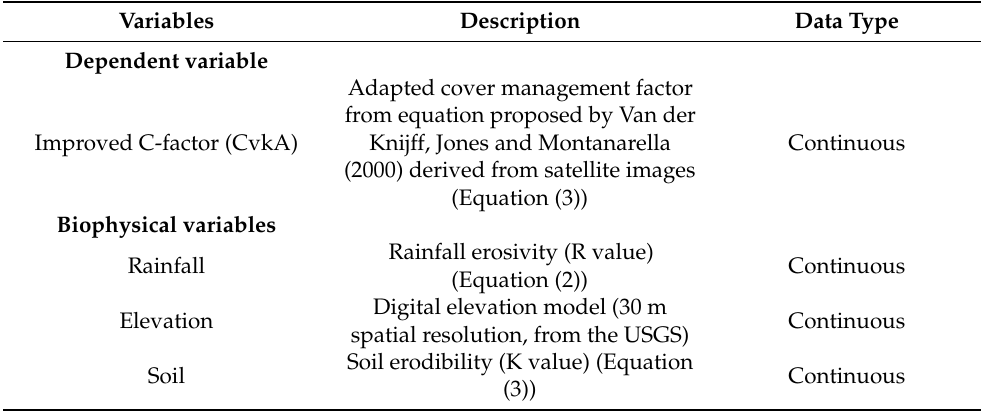
Table 2. Variables and their description used for regression analysis to investigate their influence on NDVI-derived C-factor (CvkA)